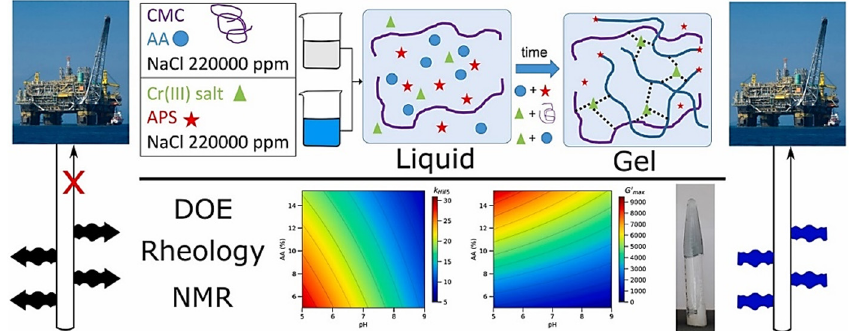
Figure 1. Mechanism diagram of free-radical crosslinking combined with acrylic acid-based chemi- cal crosslinking. (Reprinted/adapted with permission from Ref. [24], 2022, Pereira et